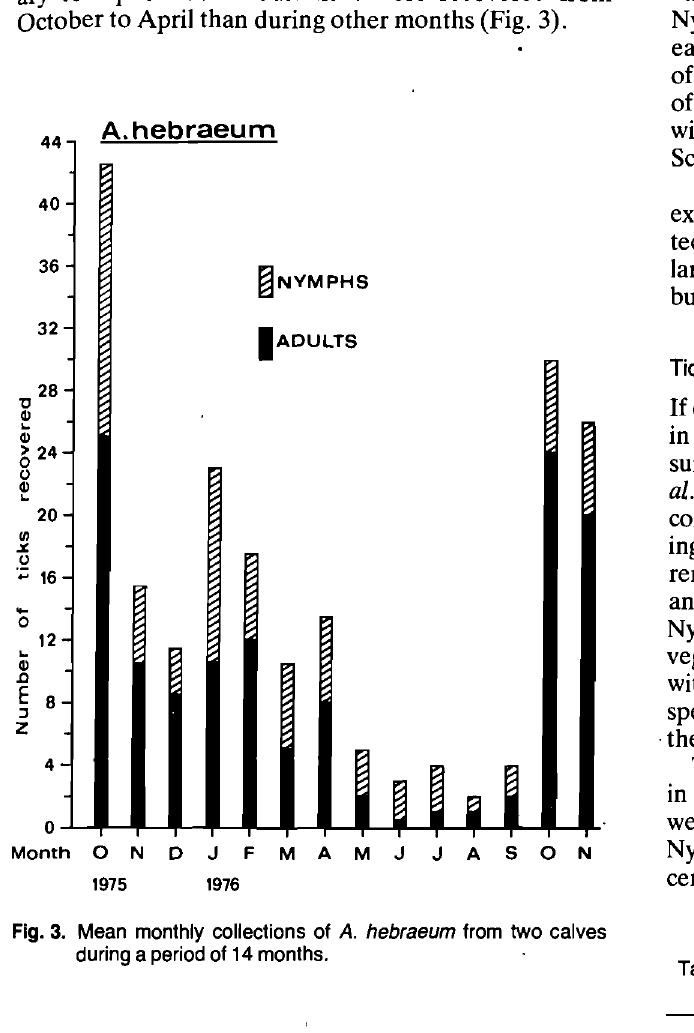
Fig. 3. Mean monthly collections of A. hebraeum from two calves during a period of 14 months. Hyalomma spp. accounted for 4,6 % of the total tick recovery. Hyalomma marginatum rufipes made up 89 % of this number, with Hyalomma truncatum re sponsible for the balance. Only adult Hyalomma spp.